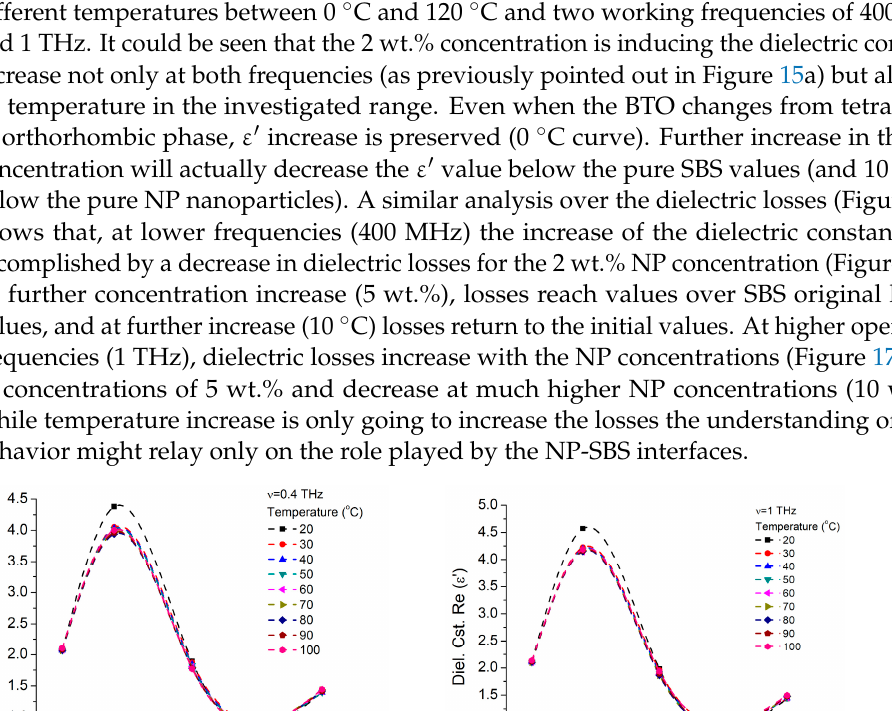
Figure 15. BTO-SBS film composite ( a ) dielectric constant ε′ and ( b ) losses variations with frequency at room temperature, for 2 wt%, 5 wt% and 10 wt%.